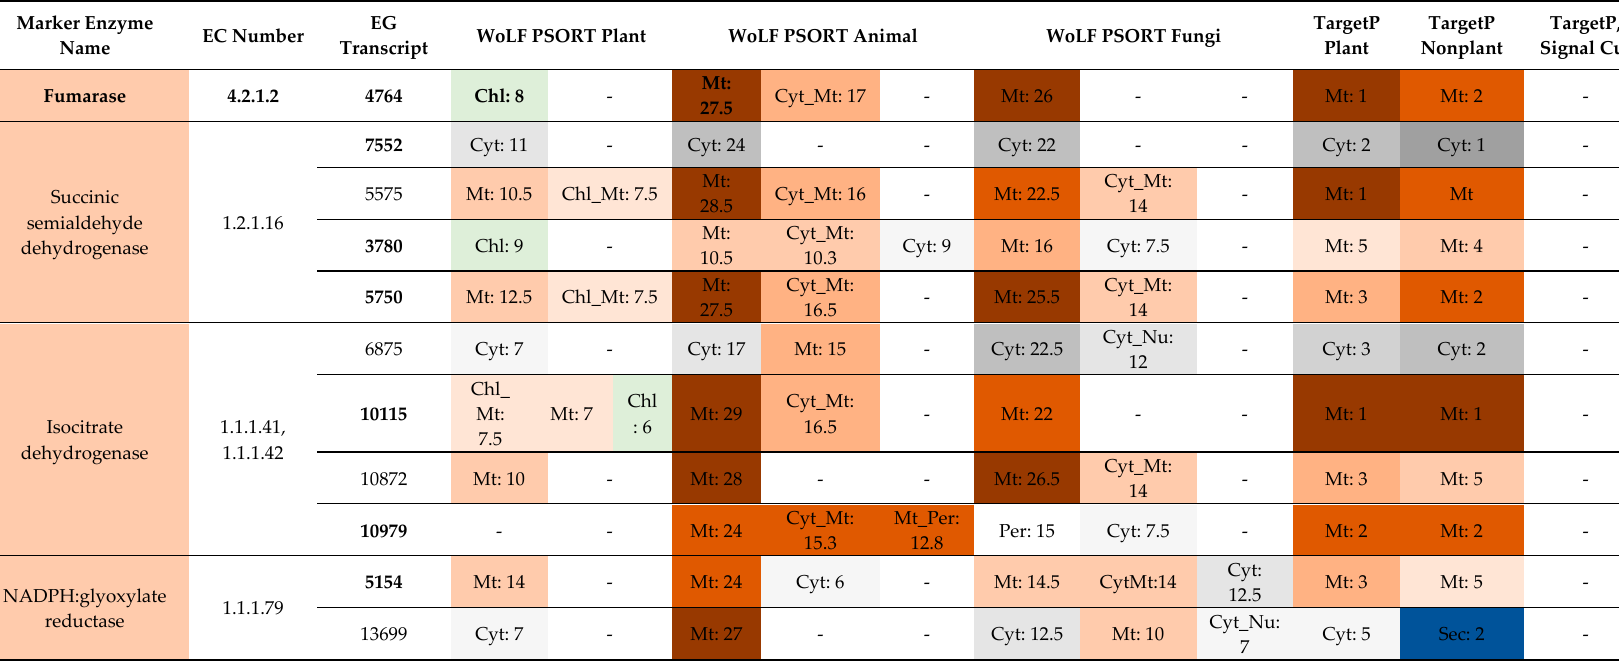
Table 1. Subcellular location prediction of E. gracilis mitochondria marker proteins.